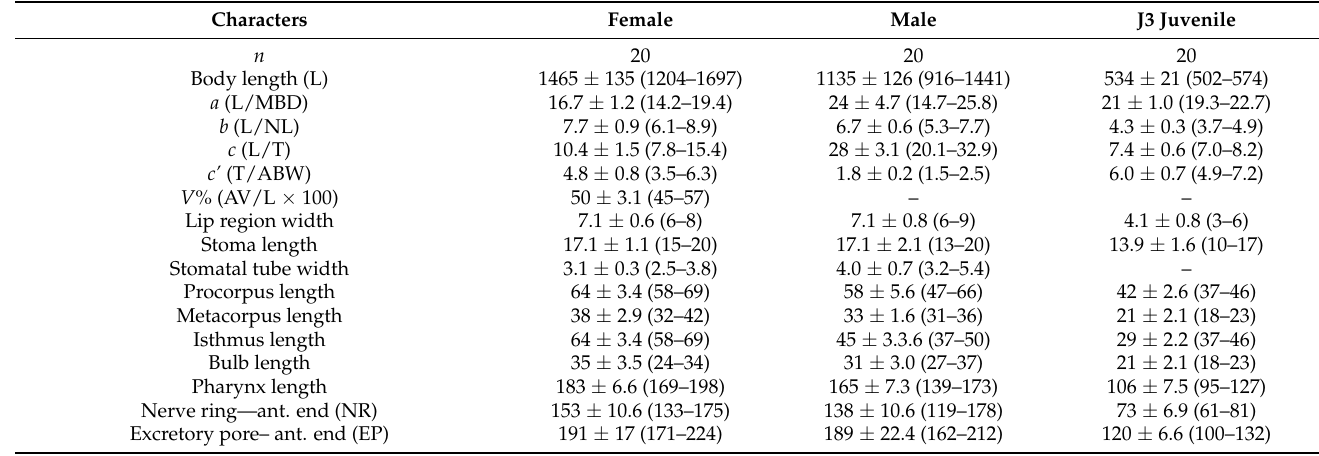
Table 1. Morphometric data of Oscheius siddiqii Tabassum and Shahina, 2010 (isolate CS42). All measurements are in µ m (except n , ratio and percentage) and in the form of mean ± SD